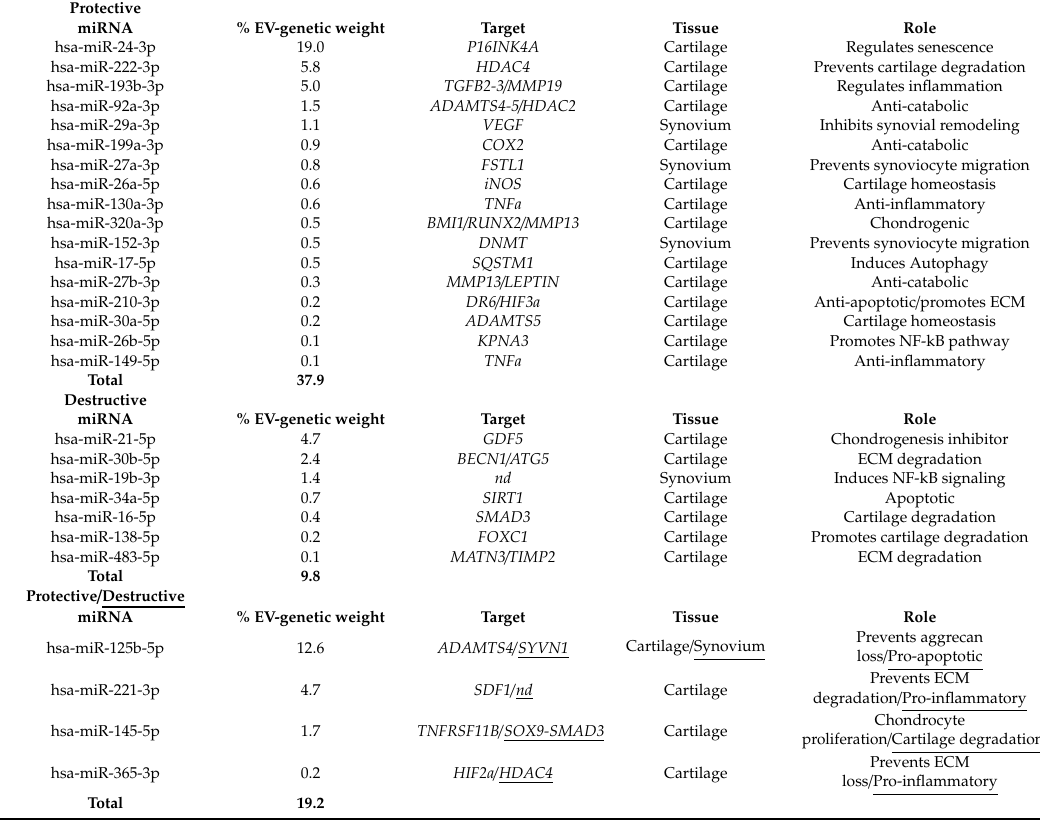
Table 3. First-quartile extracellular vesicle (EV)-miRNAs involved in osteoarthritis (OA) pathogenesis. Protective